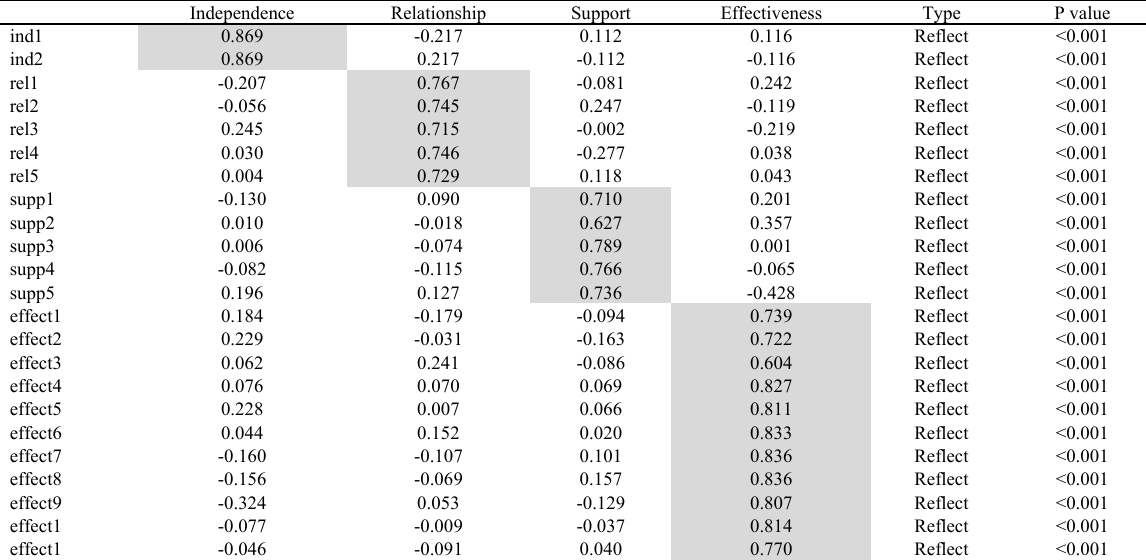
Convergent Validity of Reflective Latent Variables